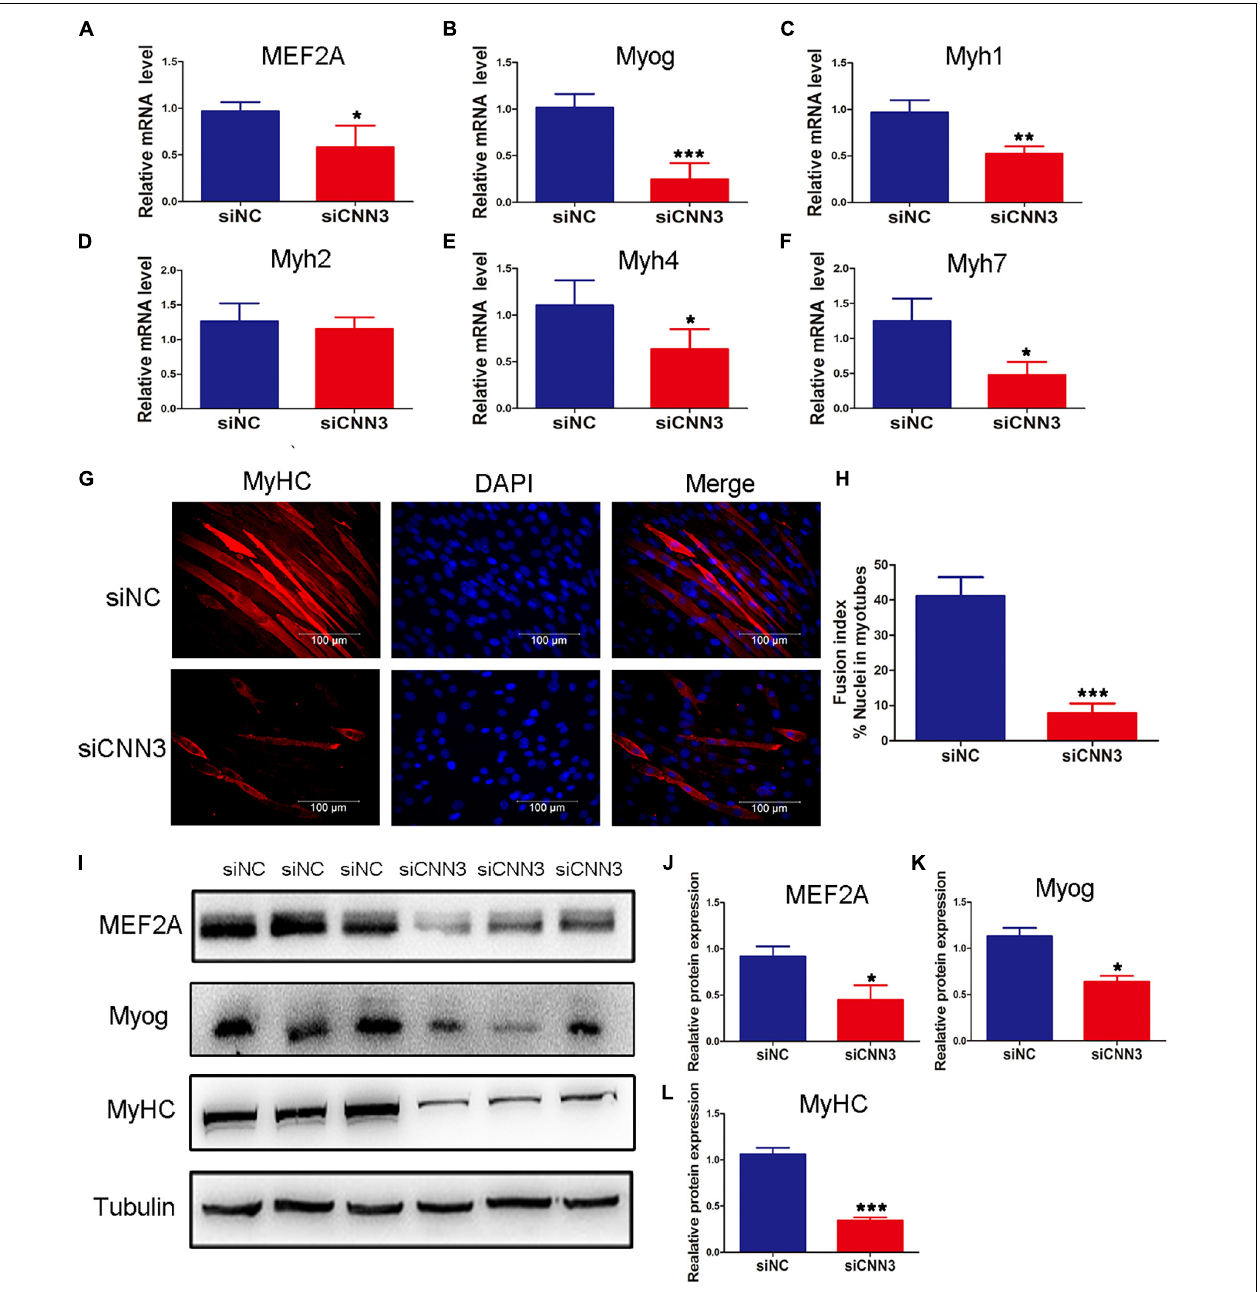
FIGURE 3 | Effects of CNN3 on differentiating myoblasts. (A–F) The relative mRNA expression of (A) MEF2A, (B) Myog, (C) Myh1, (D) Myh2, (E) Myh4, and (F) Myh7 between the NC siRNA (siNC) and CNN3 knockdown (siCNN3) groups. (G) Representative images of differentiating C2C12 cells stained with anti-MyHC antibodies. The red color indicates MyHC staining, and the blue color indicates DAPI nuclear staining. Scale bars = 100 µ m. (H) The fusion indices quantified after CNN3 knockdown. (I) Western blot analysis of MEF2A, Myog, and MyHC. (J–L) Quantification of the Western blot bands for (J) MEF2A, (K) Myog, and (L) MyHC by Image J, using tubulin as the internal control. * P < 0.05, ** P < 0.01, *** P < 0.001 compared with the siNC